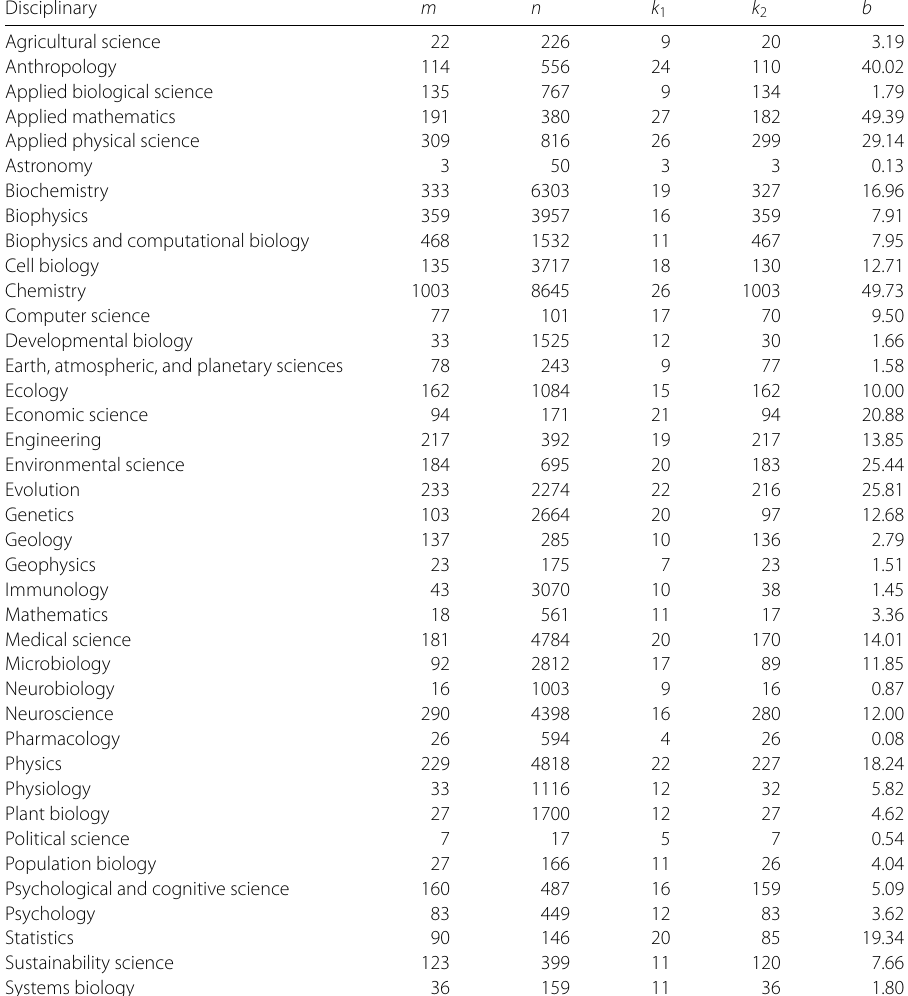
Table 1 Specific indexes of the second-class disciplines in PNAS 1999–2013 Disciplinary m n k 1 Agricultural